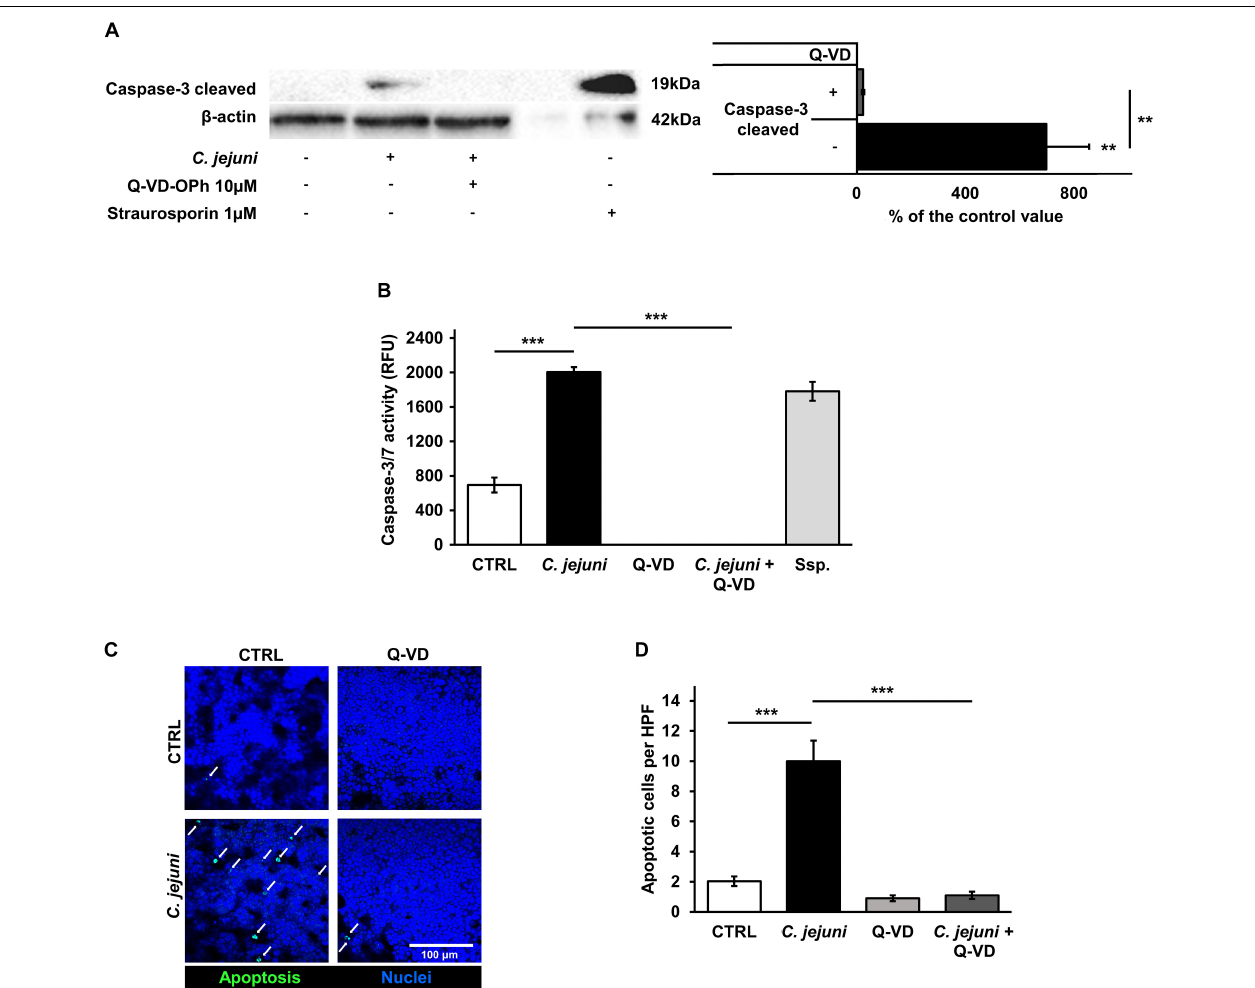
FIGURE 5 | Effects of the C. jejuni infection on caspase activity. Co-cultures of HT-29/B6-GR/MR and THP-1 cells were infected with C. jejuni with or without apoptosis inhibitor Q-VD-OPh. (A) Caspase-3 cleavage in western blot after C. jejuni infection. Immunoblotting was performed on the cell lysates 22 h after infection. Staurosporine was used for the induction of apoptosis at the concentration of 1 µ M as a positive control. Western blot densitometry represented in percent of the mean value in control samples. Western Blot intensity was normalized with β -actin level, n = 6, ** p < 0.01. (B) Caspase-3/7 activity measured in a luminescense assay on cell lysates after 22 h of infection. Staurosporine (Ssp., 1 µ M) incubated samples were used as positive controls. Data are represented in relative fluorescence units (RFU), n = 6, *** p < 0.001. (C) Apoptosis induction measured by TUNEL staining, showing DNA defragmentation in fluorescence microscopy. DAPI was applied as a nuclear counterstain. (D) Quantitative analysis of apoptotic cells in TUNEL staining (indicated by white arrows). Number of apoptosis positive cell nuclei was estimated in five high power fields per sample, containing approximately 1600 cells each. n = 6, *** p < 0.001, unpaired Student’s t -test with Bonferroni-Holm adjustment for multiple